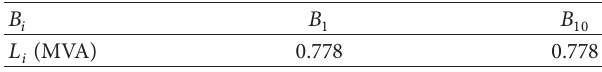
Figure 8: The medium-voltage urban power grid of one city of southern China. Table 3: Distance to boundaries of 𝐵 1 and 𝐵 10 at W 1